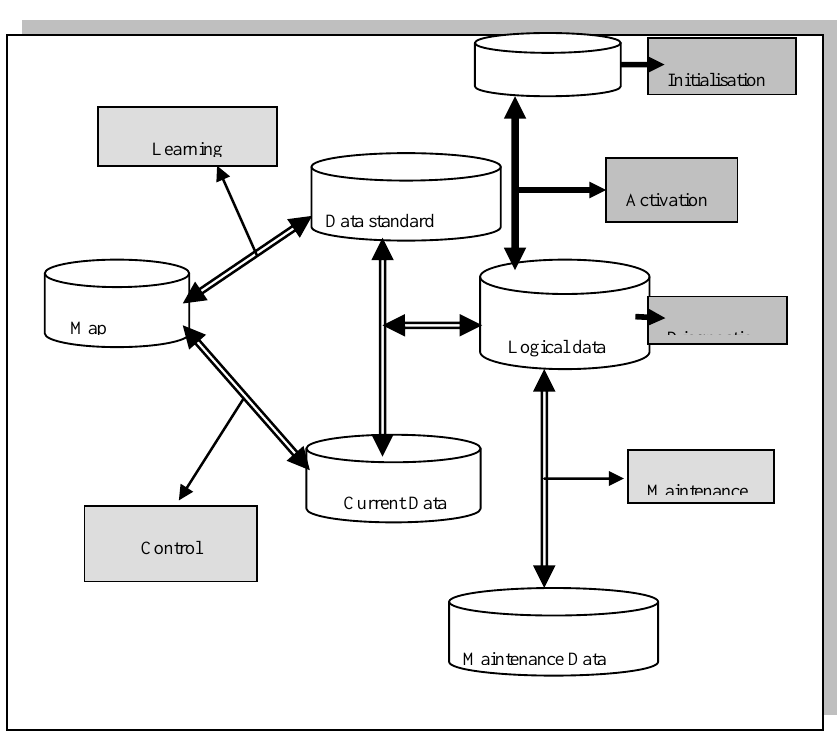
Figure 3. Model data